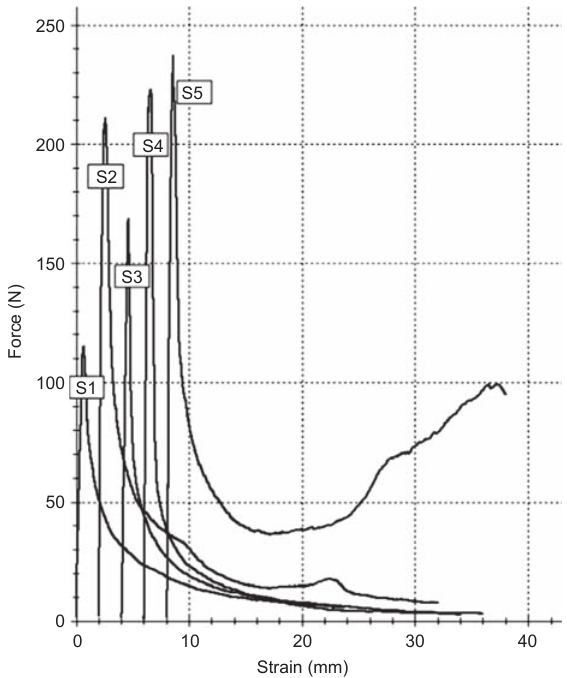
Figure 4 Load-displacement curves for tested